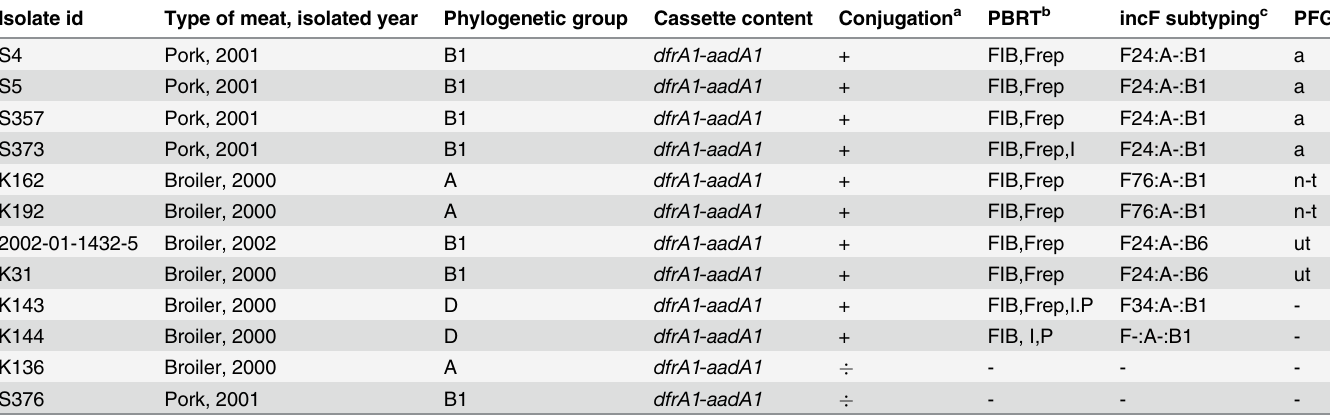
The isolates were recovered from Norwegian produced meat and meat products. a